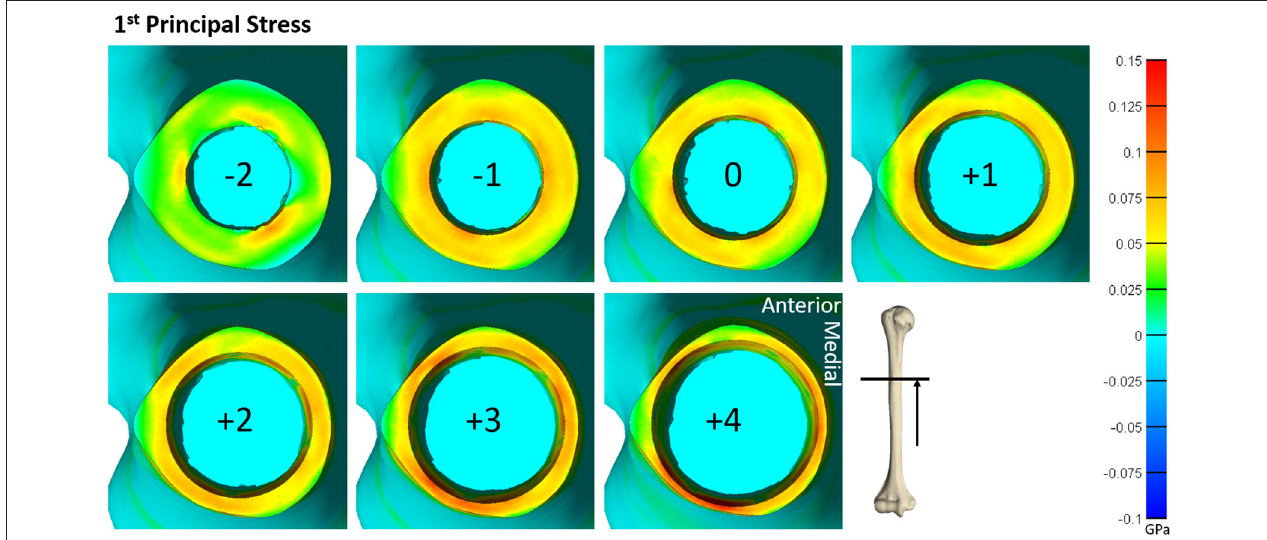
FIGURE 4 | Heat map of the first principal stress (circumferential stress) for each size of implanted endoprosthesis for one of the humerus models. For small endoprosthesis sizes, maximum stress occurred around subject-specific morphologic features. Once the endoprosthesis made contact with more areas of the bone (around size 0), a more uniform stress distribution was observed. Peak stress also began propagating through the thickness of the bone at the distal end around size + 3.